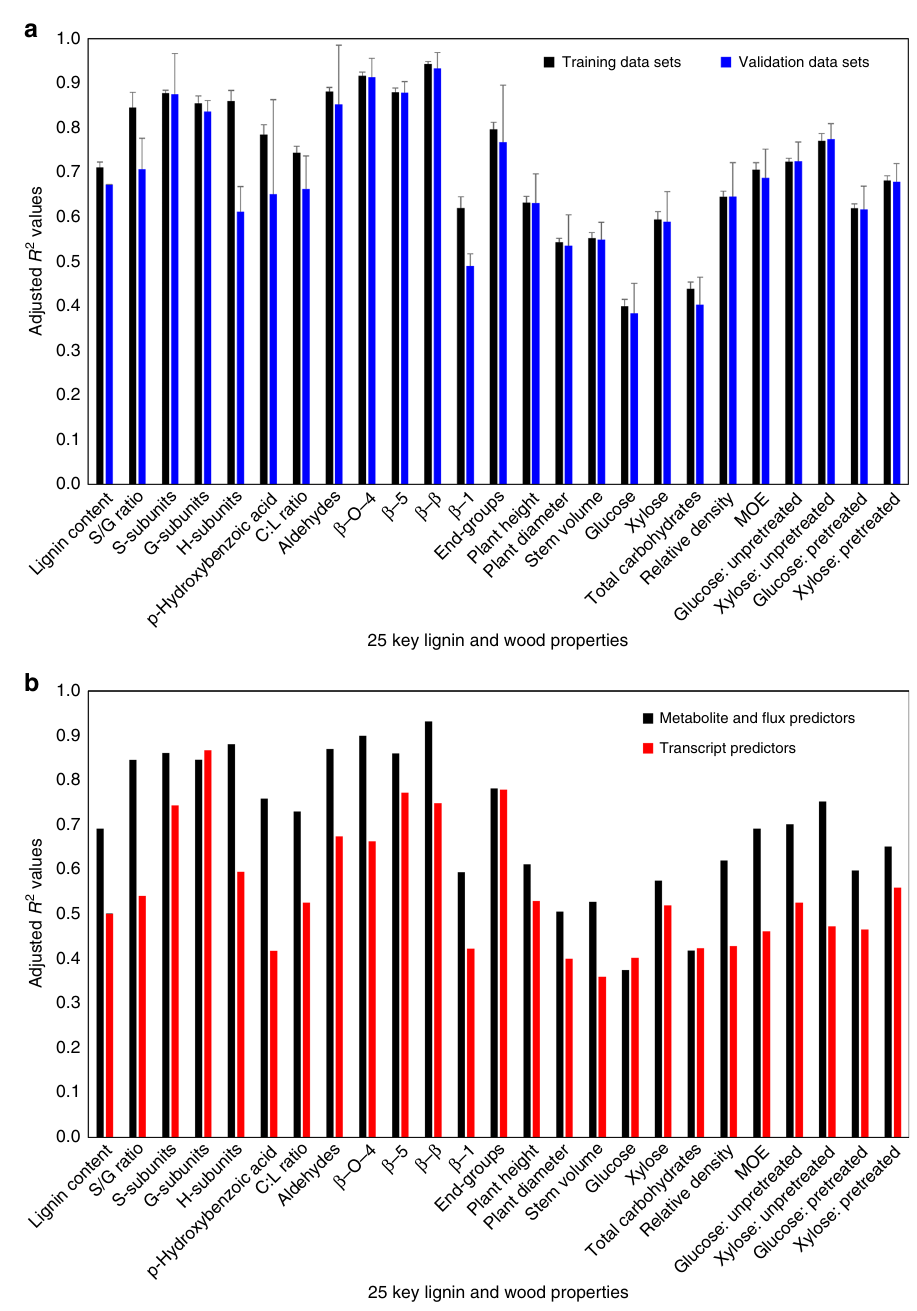
Fig. 8 Integrative analysis validation. a Average adjusted R 2 values for the training data sets (black bars) and the validation data sets (blue bars) for a fi ve- fold cross-validation. Error bars denote the standard error of fi ve sets of validations. b Adjusted R 2 values for the lignin and wood properties predicted using either absolute transcript abundances as predictors (red bars) or metabolic- fl uxes and metabolite concentrations as predictors (black bars). For both regression equations, an all-possible-model algorithm was used to determine the speci fi c predictor variables. See Methods for detail. Adjusted R 2 values represent variation explained by the regressions after adjusting for a different number of